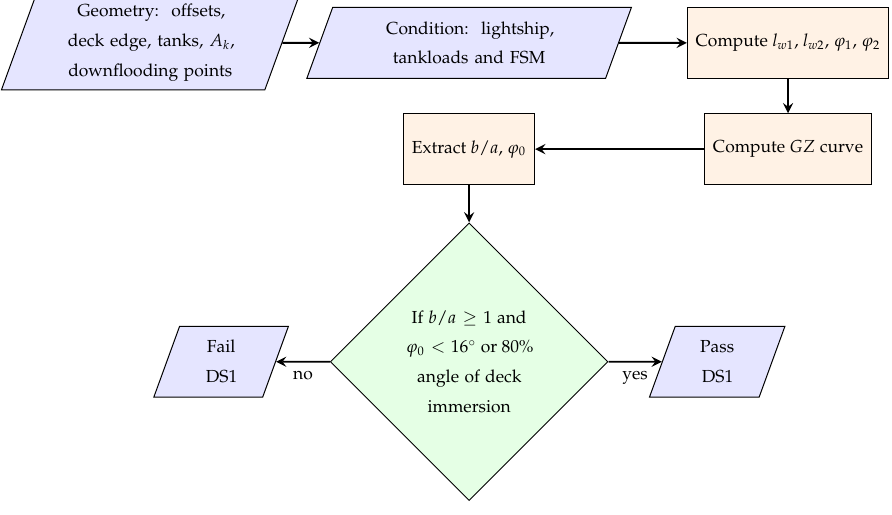
Figure 3. Dead Ship Level 1 algorithm process